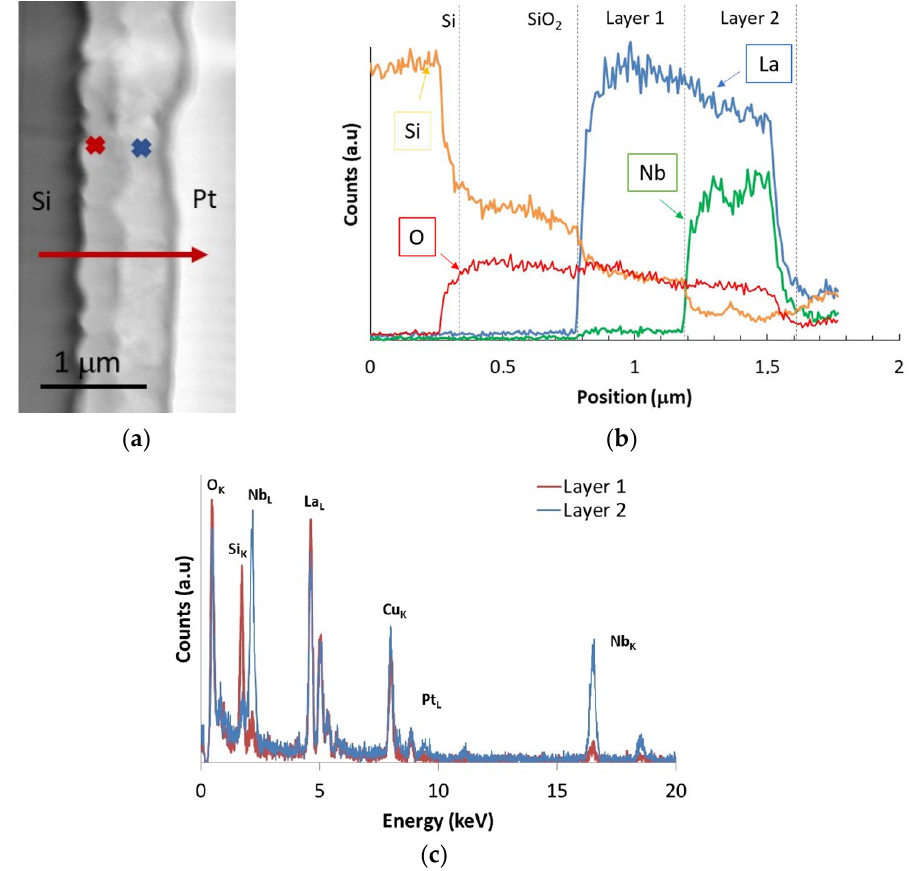
Figure 6. ( a ) Cross-section STEM image; ( b ) chemical profile through the red arrow of Figure 7a; ( c ) punctual spectra of the red- and blue-arrow-marked points identified in Figure 7a for the HT Nd-doped La 3 NbO 7 thin film.